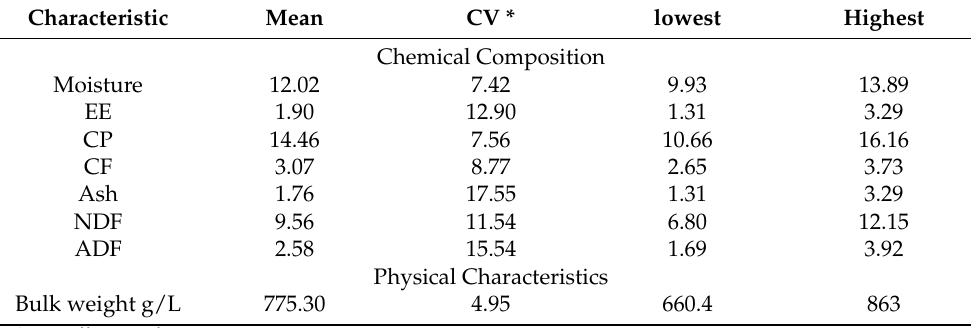
Table 2. Chemical and physical characteristic of 40 wheat samples (on dry matter) (%).